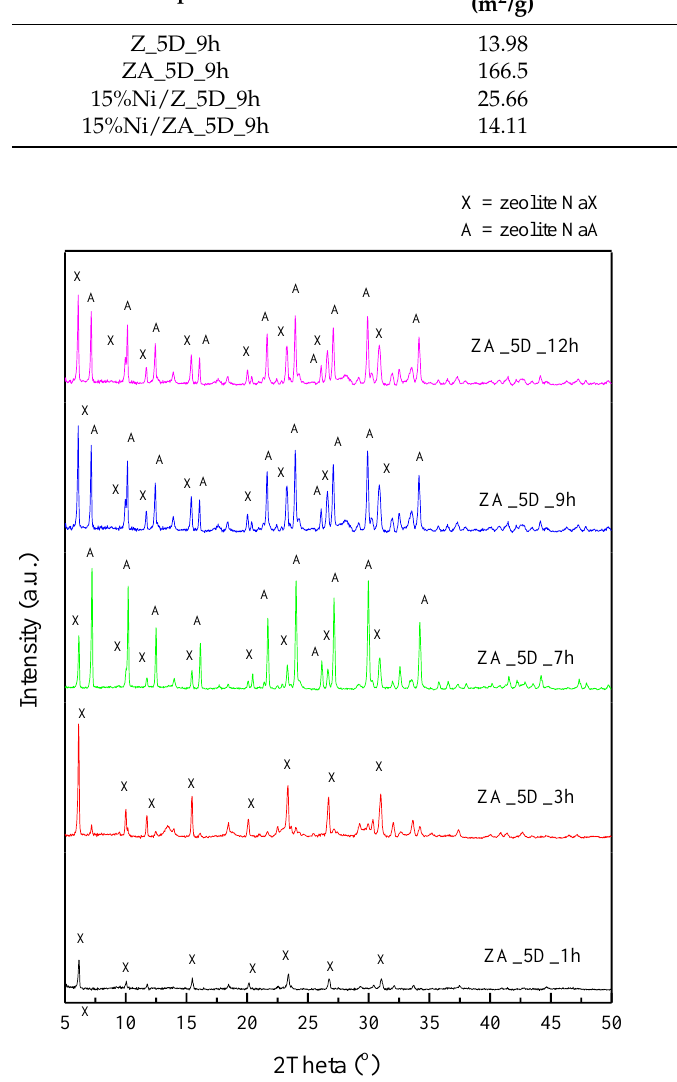
Figure 2. X-ray diffraction patterns of synthesized samples with different crystallization times. Table 1. Surface area and pore volume of synthesized zeolite.